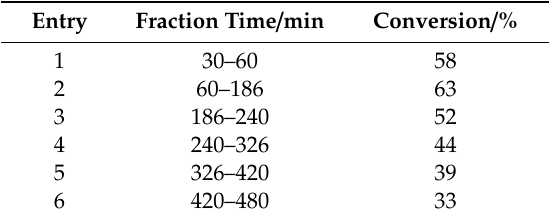
Table A15. Reduction of acetophenone ( 1 ) to 1-phenylethanol ( R )- 2 . Change from standard